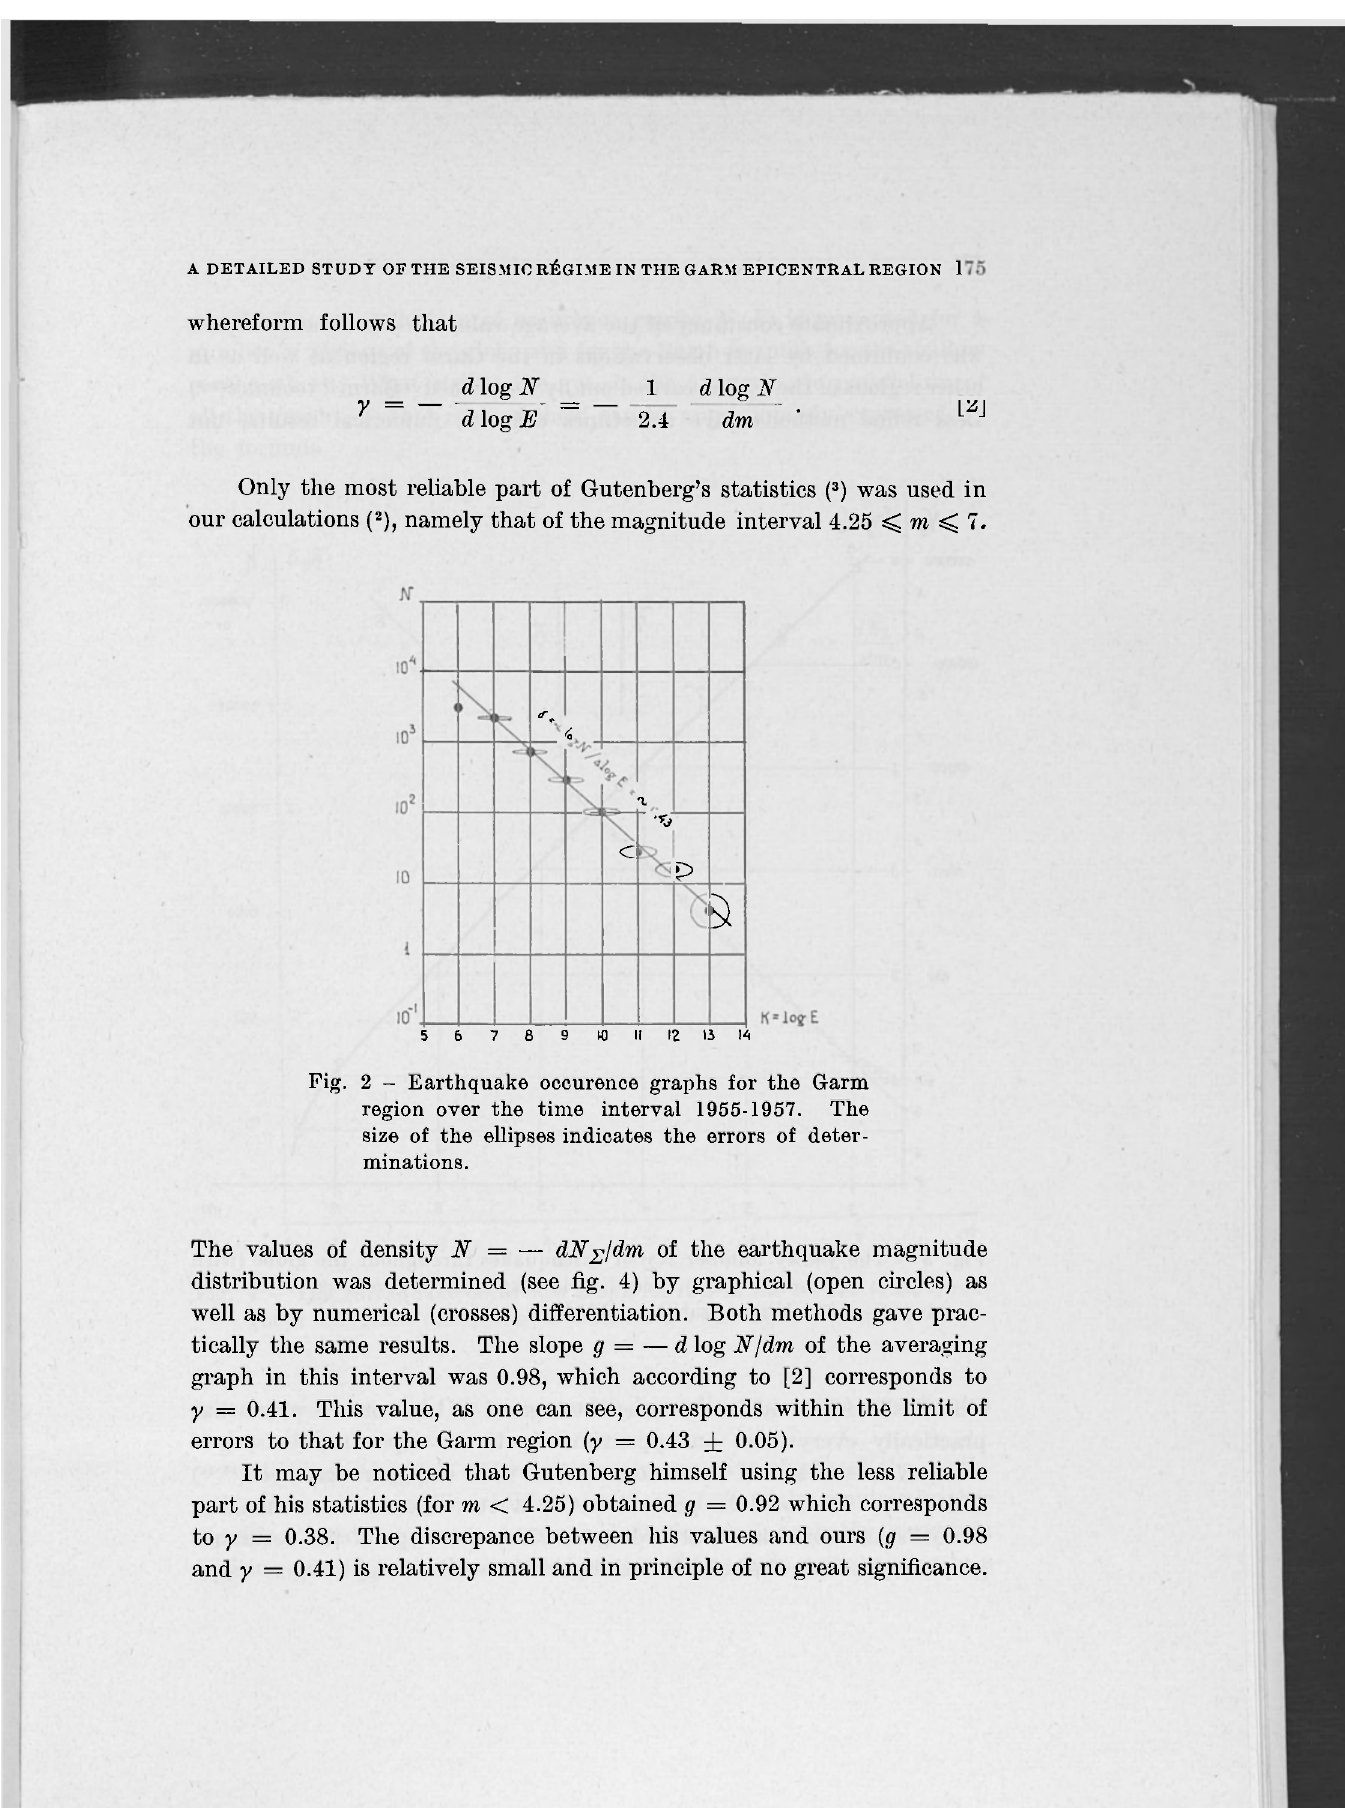
Fig. 2 - Earthquake occurence graphs for the Garm region over the time interval 1955-1957. The size of the ellipses indicates the errors of deter-